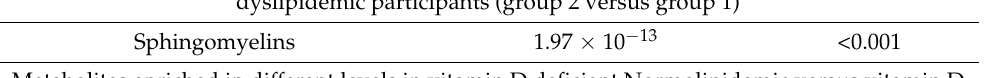
Table 2. Metabolites enrichment among various groups based on vitamin D status with or without dyslipidemia. Pathway p Value FDR Metabolites enriched in vitamin D sufficient groups; Normolipidemic versus vitamin D sufficient